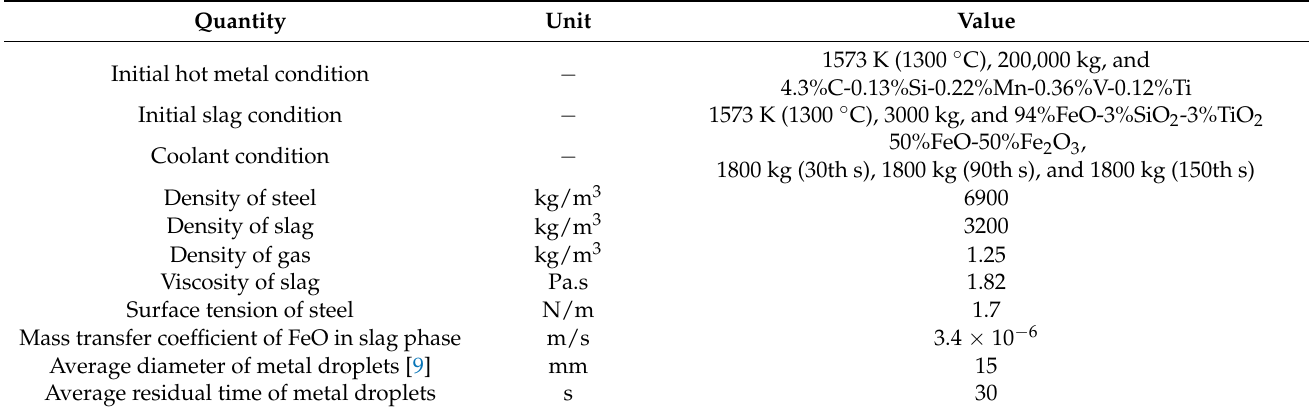
Table 1. List of input parameters used for calculations.